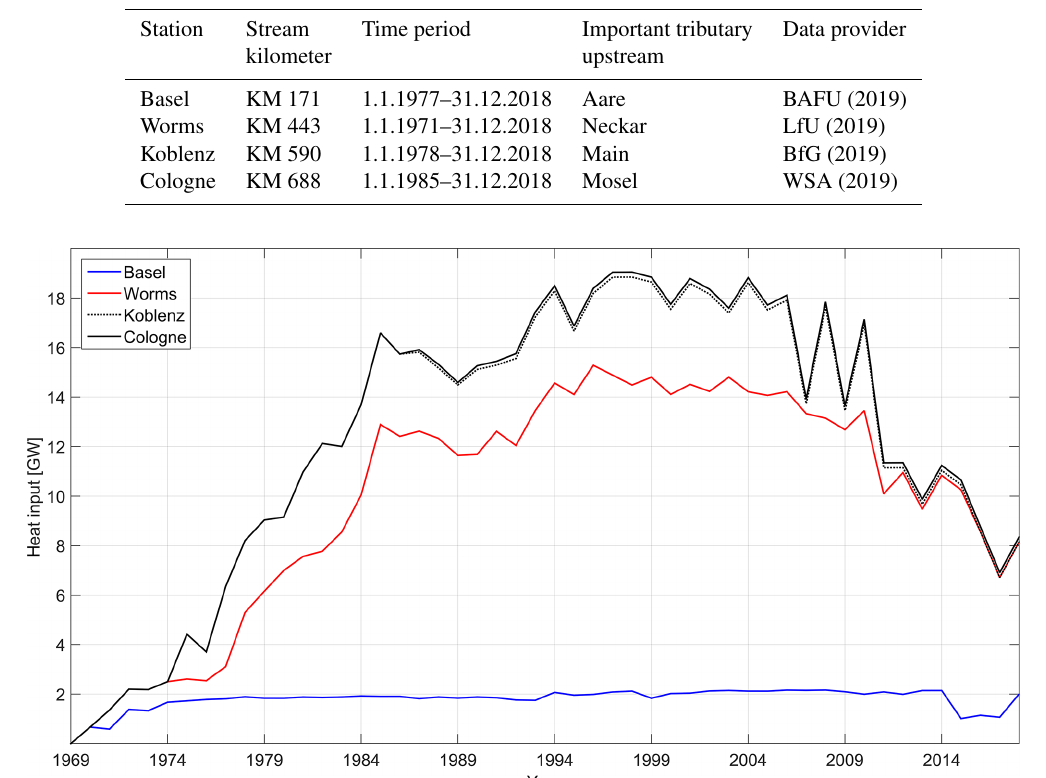
Table 1. Monitoring stations used in this study from Switzerland (Basel) to the lower Rhine region (Cologne, Germany). The location is shown as a Rhine kilometer (KM), and the time period, the important upstream tributary and the data source are listed.